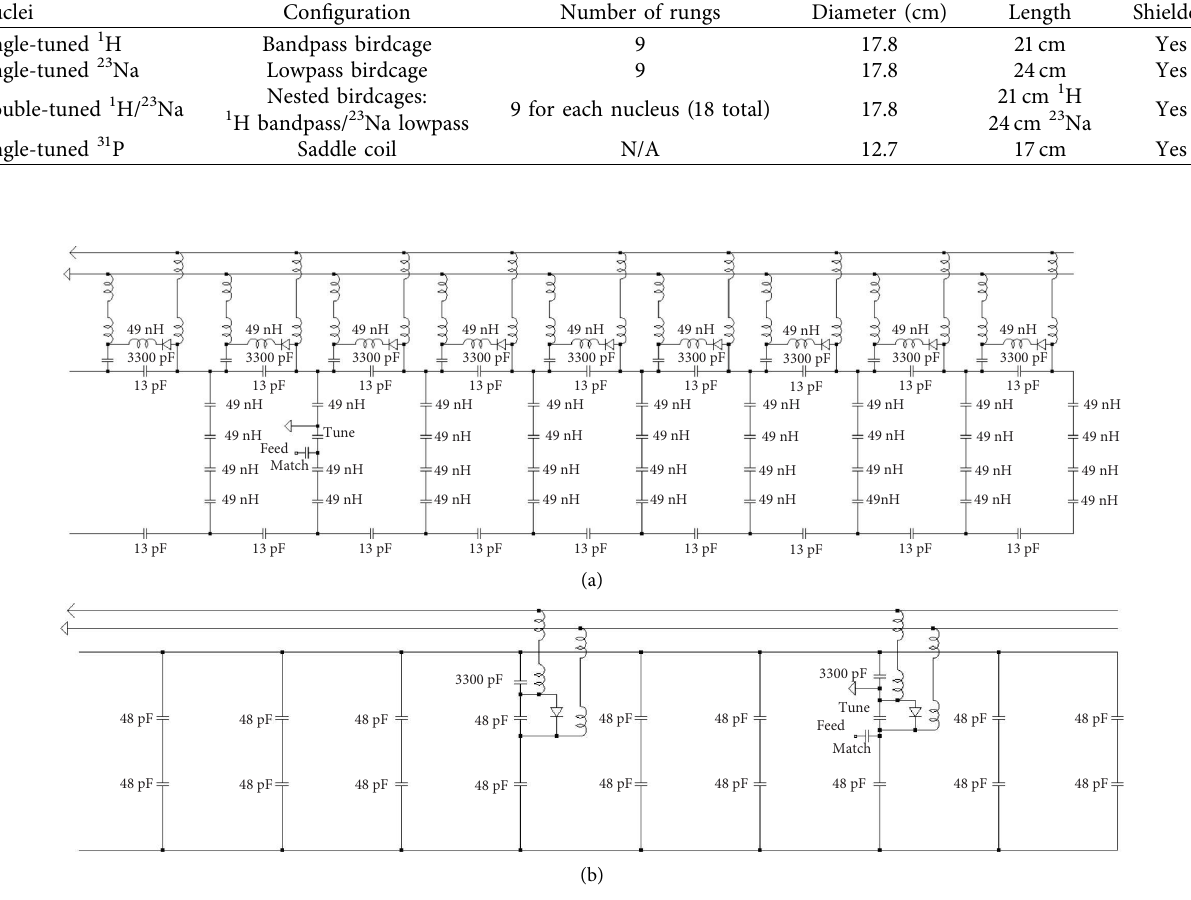
Figure 1: (a) Schematic for the hydrogen birdcage with active detuning circuitry. Unlabeled inductors are 6.8 μ H RF chokes. (b) Schematic for the sodium coil with active detuning schematic. Unlabeled inductors are 6.8 μ H RF